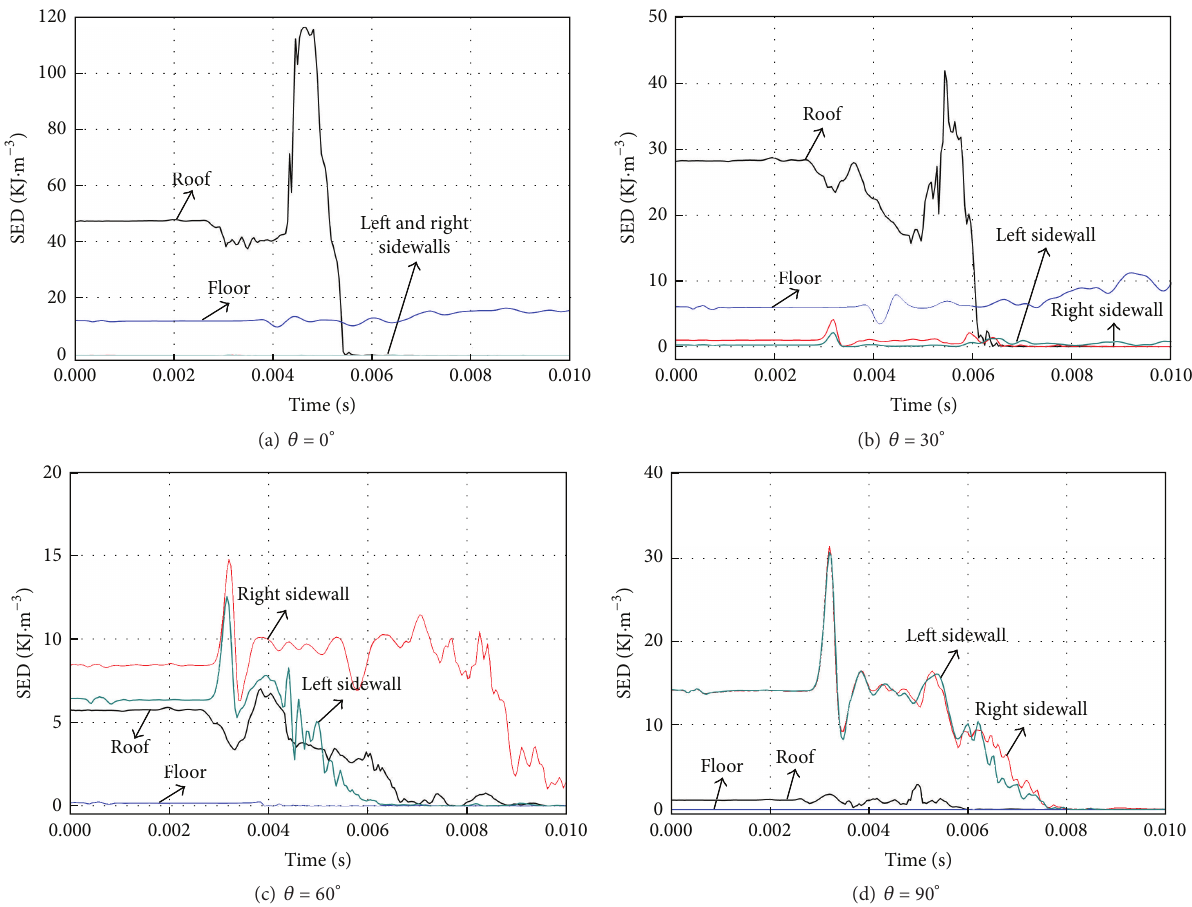
Figure 7: SED evolutional curves for the four locations under various geostress